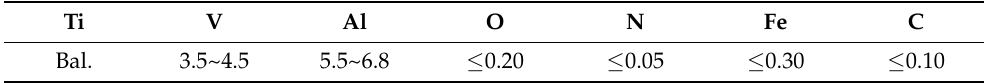
Table 1. Chemical composition of the TC4 metal wire.